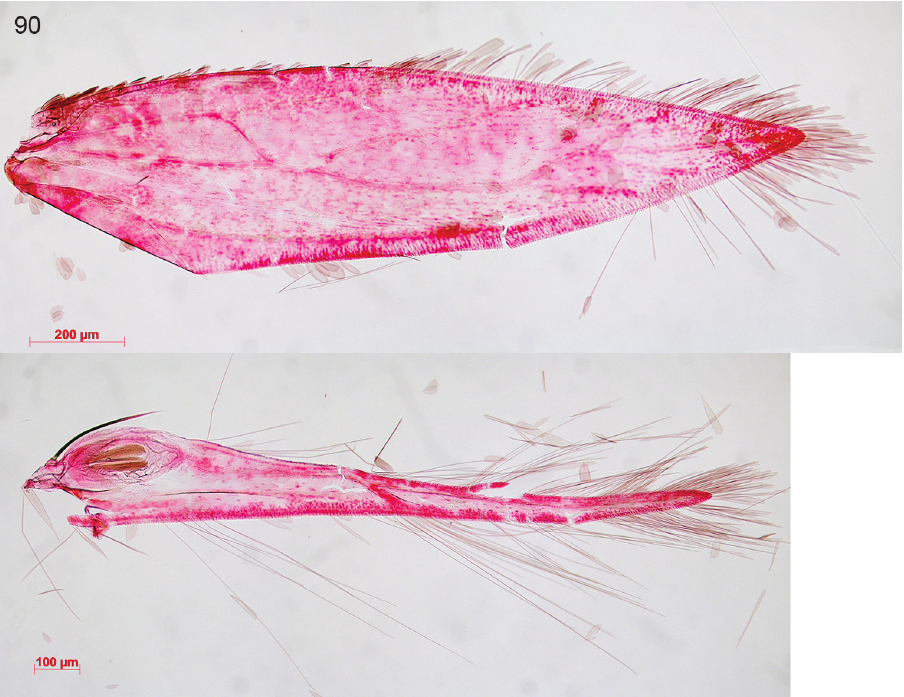
Figure 90. Glaucolepis argentosa Puplesis & Robinson, 2000, paratype, venation of right wings, slide 4502, RMNH.INS. 24502. Note the absence of Cu in forewing, absence of trifurculate Rs+M in hind- wing and presence of two groups of special scales on humeral